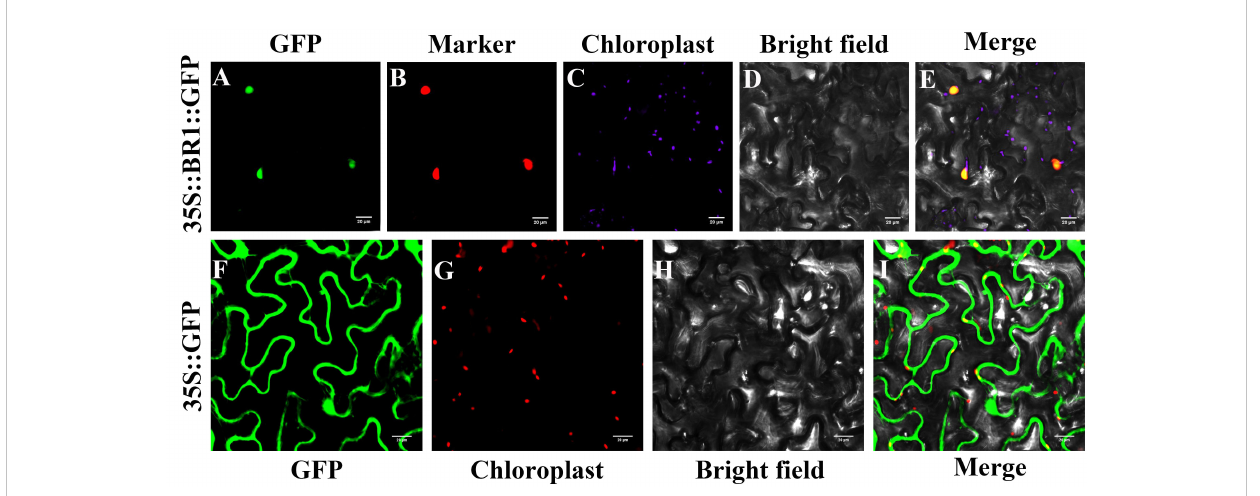
FIGURE 6 BR1 subcellular localization analyses. (A, F) GFP fl uorescence. (B) Nuclear marker fl uorescence. (C, G) chloroplast signals. (D, H) Bright fi eld images. (E, I) Merged images. A Leica confocal microscope was used to collect images at 48 h following agro-in fi ltration. Control GFP localization was evident throughout these cells. Scale bar: 20 m